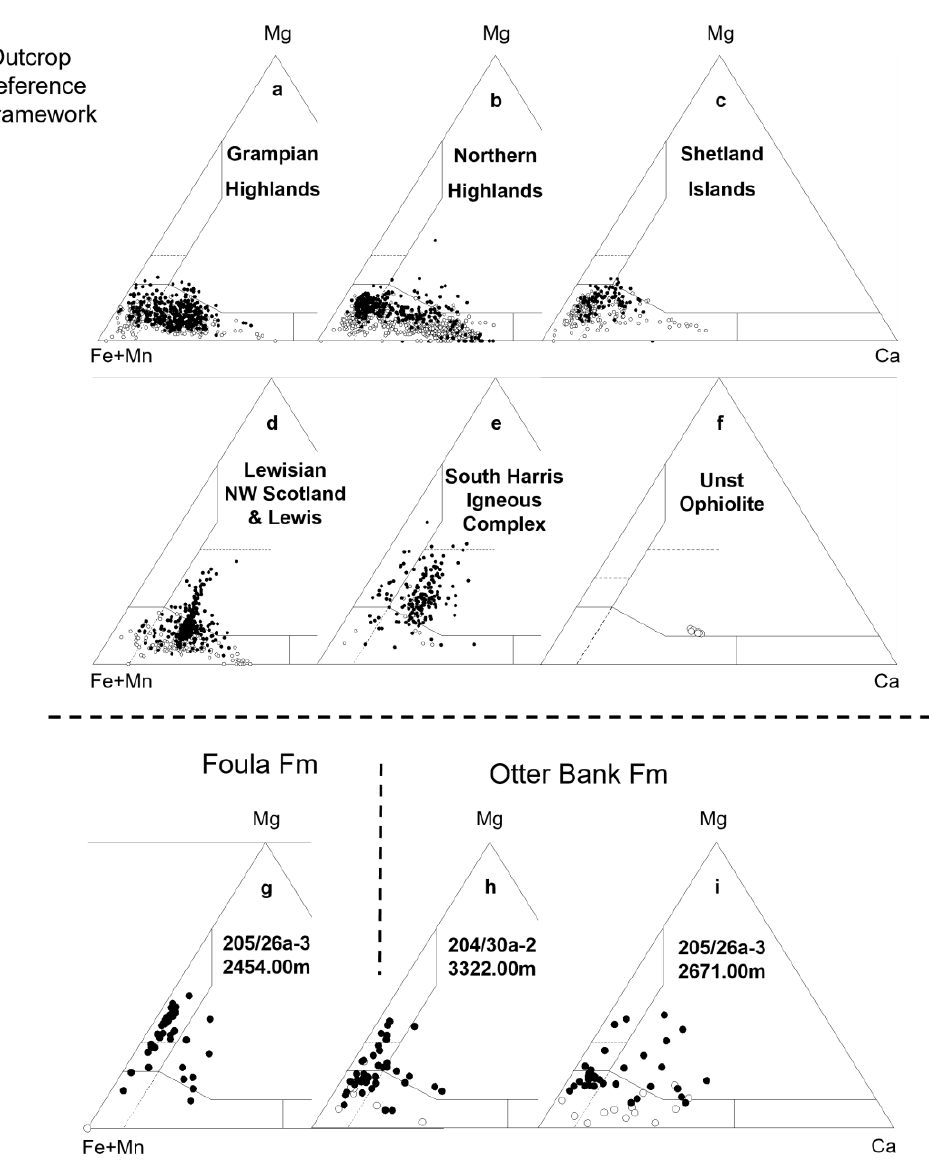
Figure 15. Garnet assemblages in modern river sediments draining Lewisian, Moine and Dalradian basement rocks of northern Scotland and the Shetland Isles, plus garnets in the Triassic Foula and Otter Bank Formations (west of Shetland) and the Unst Ophiolite (Shetland) from Morton et al. [28], Morton et al. [70] and Spray [49]. ( a ) Rivers draining the Grampian Highlands (predominantly Dalradian-sourced); ( b ) Rivers draining the Northern Highlands (predominantly Moine-sourced); ( c ) Rivers draining Dalradian and Moine rocks on Shetland; ( d ) Rivers draining Lewisian basement of northwest Scotland and Lewis; ( e ) Rivers draining the South Harris Igneous Complex; ( f ) garnetifer- ous facies of the Unst Ophiolite, Shetland; ( g ) Foula Formation in UK Well 205/26a-3 (2454.0 m); ( h ) Otter Bank Formation in 204/30a-2 (3322 m) and ( i ) Otter Bank Fm in 205/26a-3 (2671.6 m). Mg — py- rope, Fe + Mn — Almandine + Spessartine, Ca — Grossular. See Figure 6 for definition of garnet types. Filled circles-garnets with <5% Spessartine; open circles-garnets with >5% Spessartine. The Early Triassic Otter Bank Formation conformably underlies the Foula Formation to the west of the ESP. Otter Bank sandstones lack common Type Ai garnets and have assemblages rich in Type B garnet with variable but subordinate amounts of Type Aii and Type C (Figure 15). Recycling of sandstone with Otter Bank characteristics is therefore a likely origin for the younger Palaeocene and Eocene sandstone in the study area, includ- ing those in the Hermod S2 Mbr. Removal of the overlying Foula equivalent during the